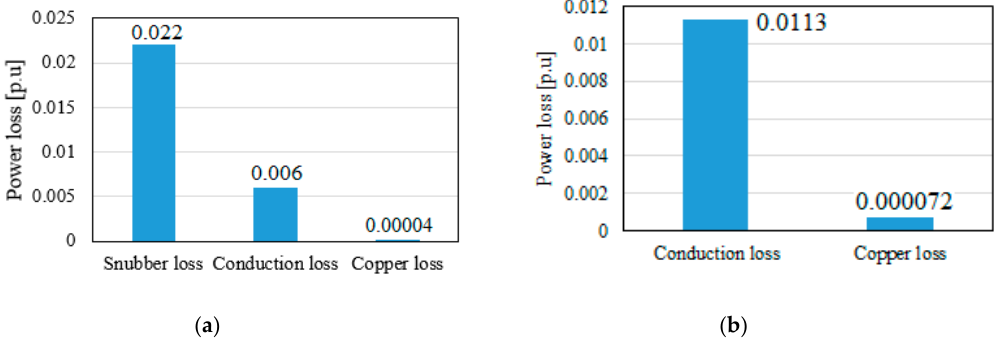
Figure 14. Power loss distribution of the 3P-BIDC in continuous operation; snubber, copper, and conduction losses at ( a ) 0.12 p.u. ( b ) 0.34 p.u.